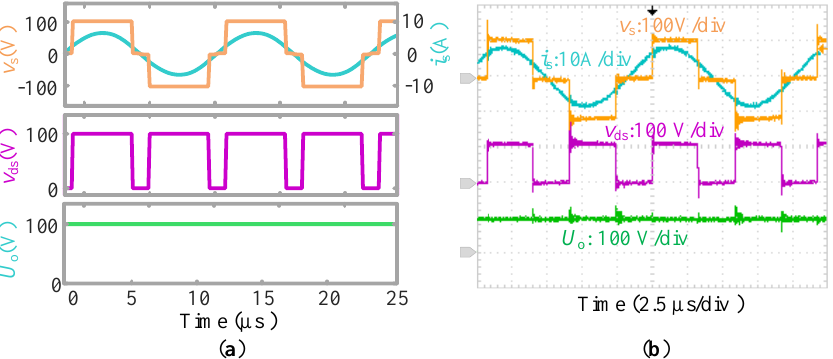
Figure 15. Typical waveforms of APC receiver: ( a ) simulated; and ( b ) experimental. I s : secondary resonant current (blue lines); v s , secondary resonant voltage (yellow lines); v ds , voltage across S 5 (purple lines); U o , output voltage (green lines).